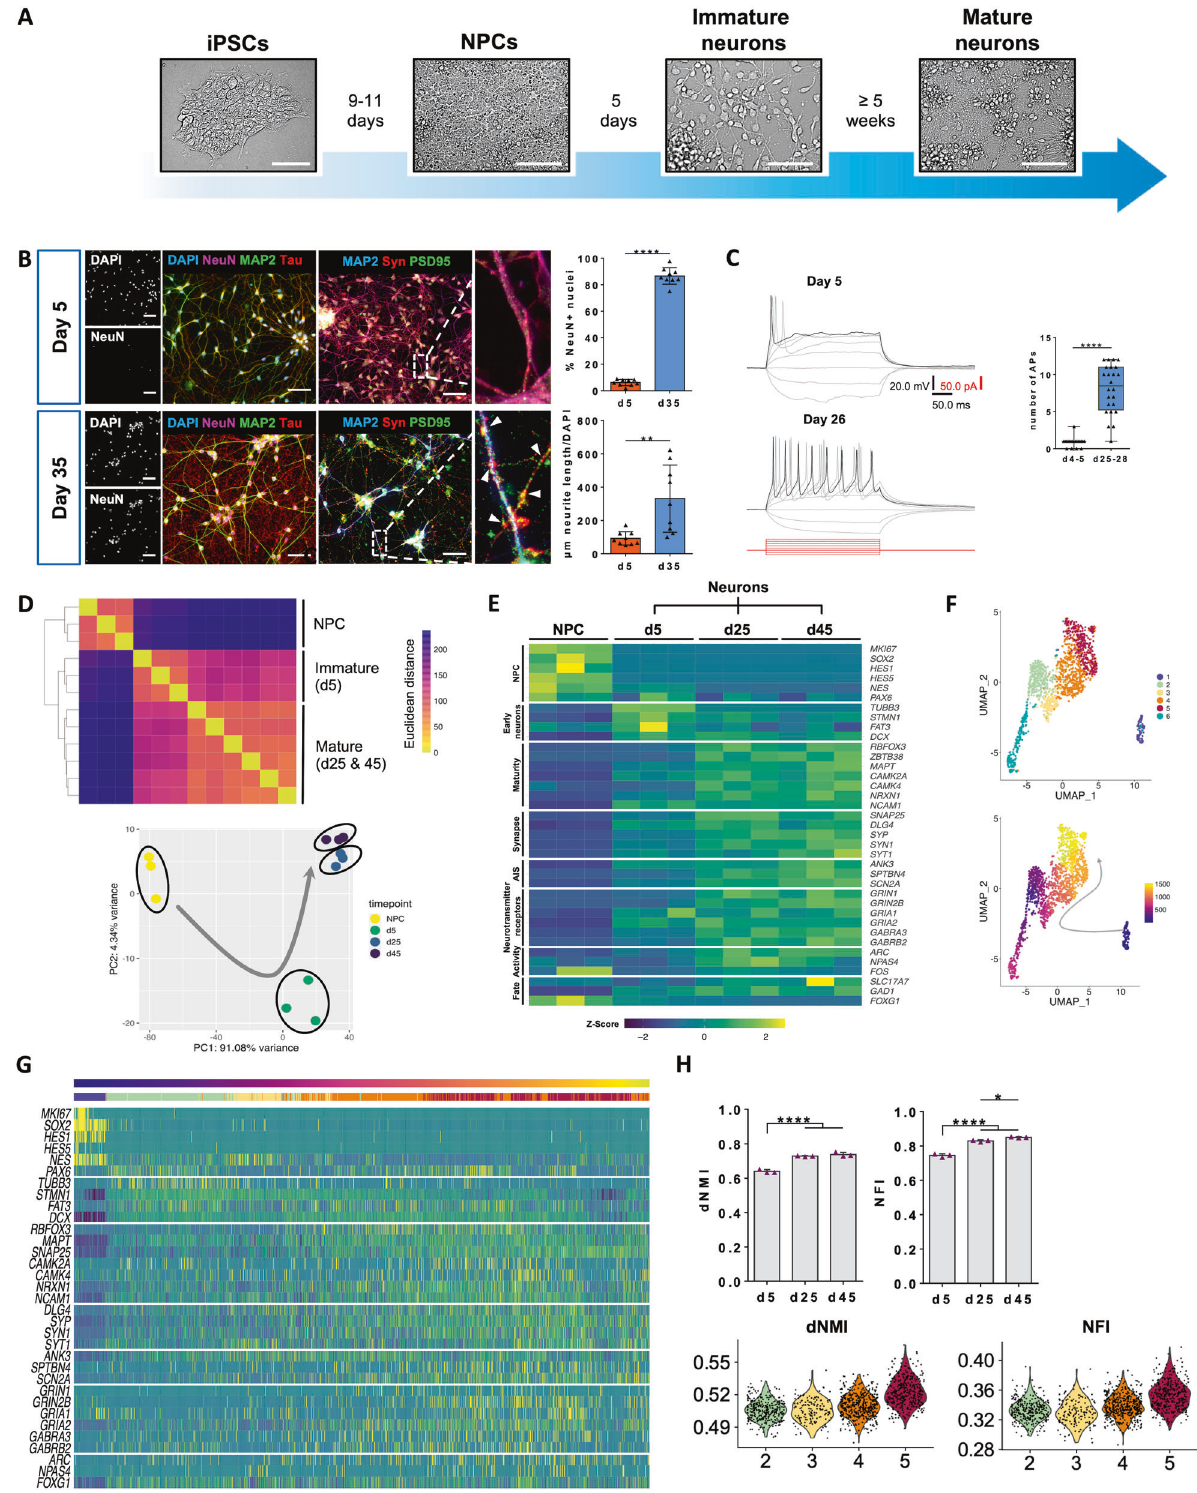
the MAP2 + dendritic arbor (Fig. 1B), indicating neuronal polarity. At d35 cultures also displayed a signi fi cantly expanded network of neurites compared to neurons at d5. At the same time, the percentage of cells expressing the maturation-associated neuronal splicing regulator NeuN increased from about 5% to >80%. Immuno fl uorescence examination of the pre-synaptic marker Cell Death and Disease (2022)